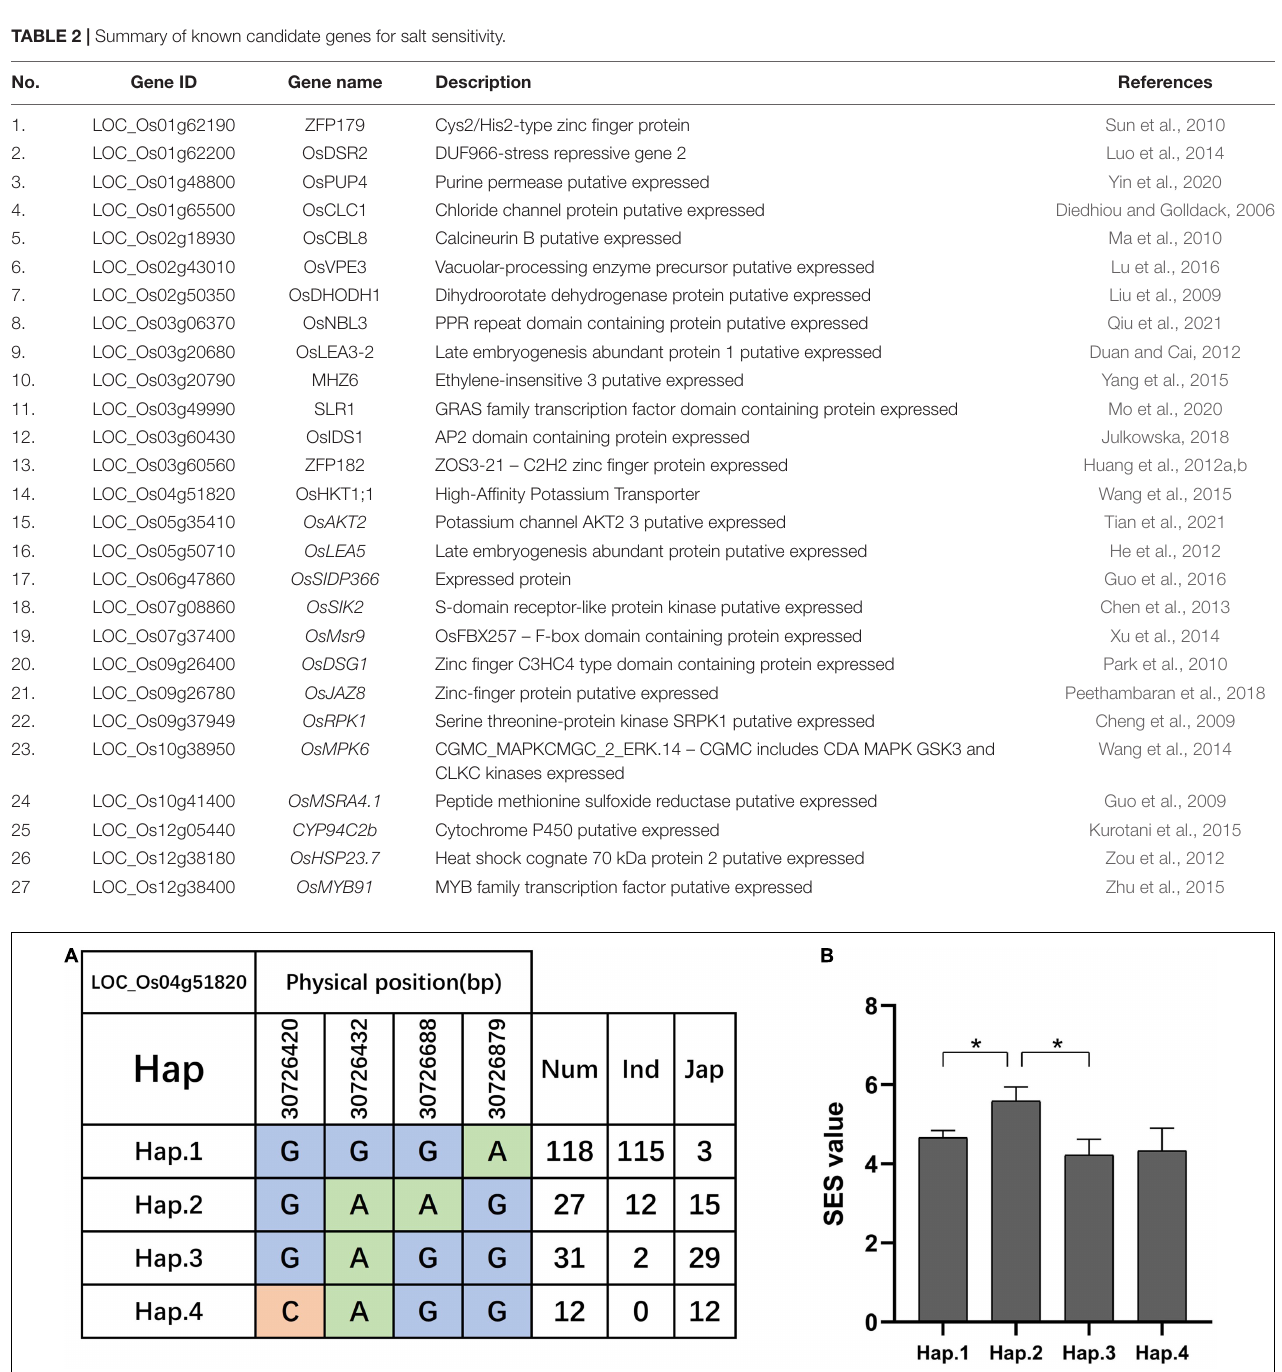
transcriptional changes in rice under salinity stress, we selected two varieties of plants from the 191 accessions panel, specifically 93-11 and PA64s. These plants exhibited significant phenotypic differences under 0 mM (93-11 ST 0 ; PA64s ST 0 ) and 100 mM (93- 11 ST 100 ; PA64s ST 100 ) NaCl conditions and were used for further RNA-Seq analysis. Clearly observable symptoms of salt injury